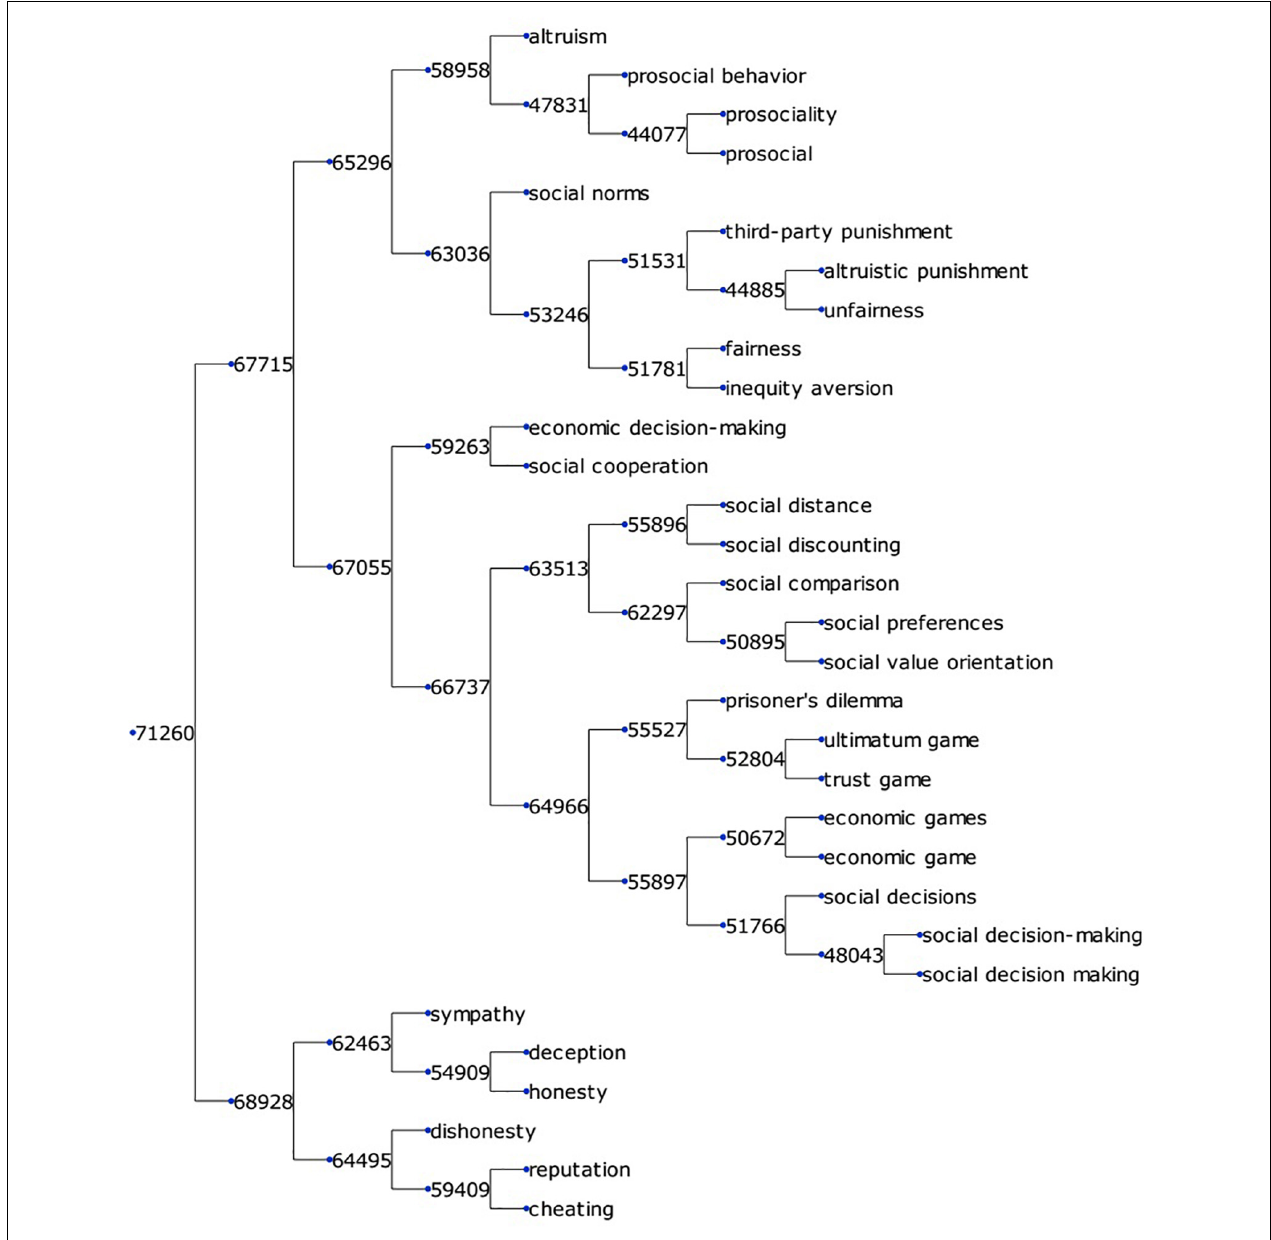
FIGURE 3 | A small fraction of the keyword clustering tree. The binary tree is visualized using the Python package ETE3 (Huerta-Cepas et al.,